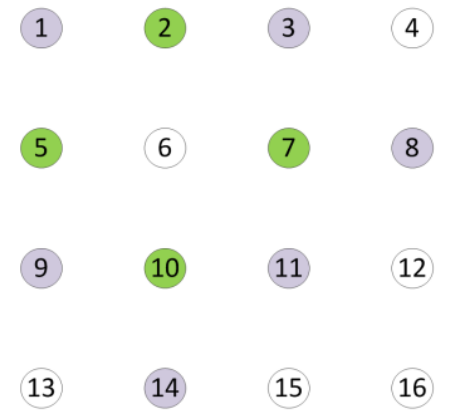
Figure 2. A uniform planar array with 16 antennas. The green circles represent one-hop neighbor antennas of antenna 6, and the grey circles represent two-hops neighbor antennas of antenna